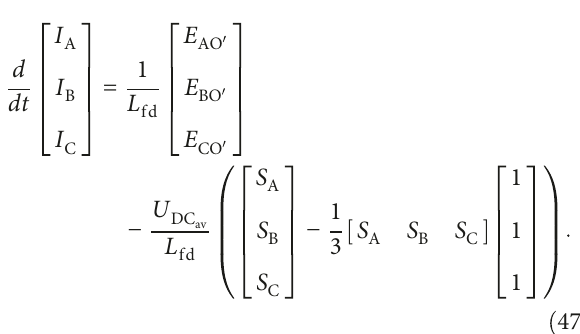
Figure 7 and applying Kirchho ff ’ s voltage and current laws